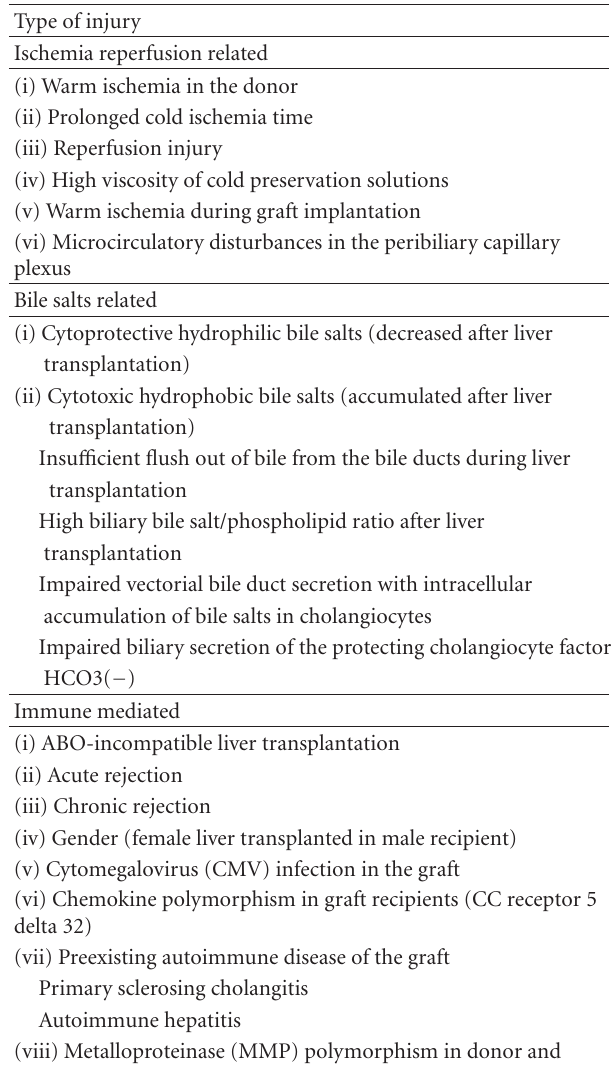
Table 1: Pathomechanisms leading to ITBLs after liver transplanta-